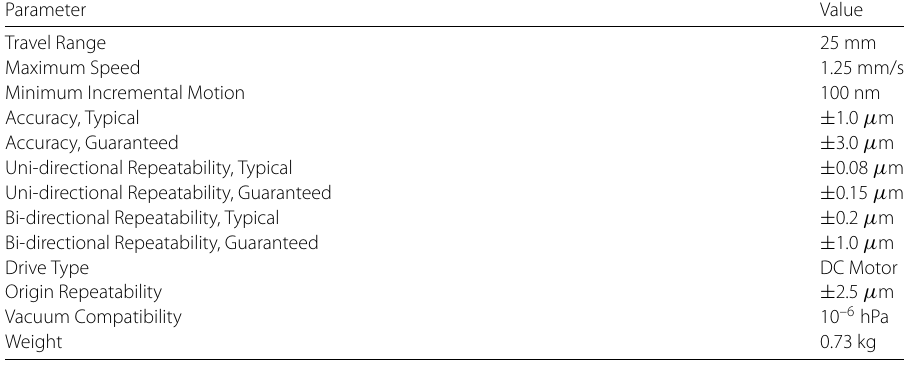
Table 3 Specifications of Newport ® Motion Stage TRA6PPV6 (from data sheet)